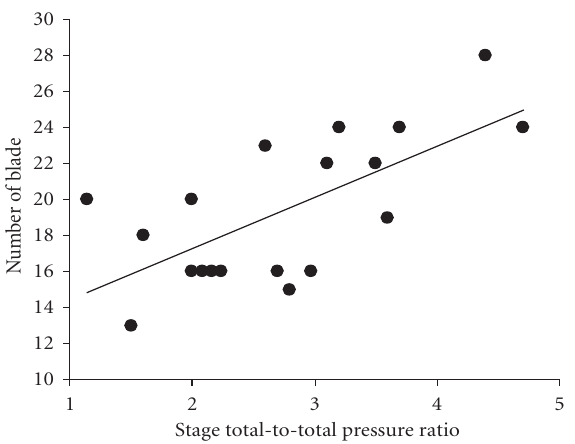
Figure 6: The number of blades at the inlet versus stage pressure ratio.